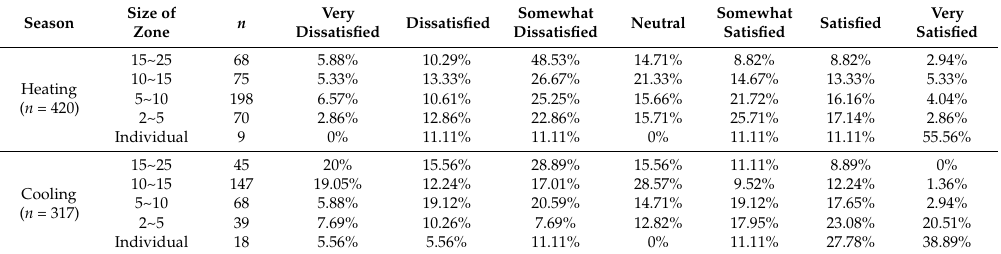
Figure 5. User satisfactions on air temperature by the size of zone (heating and cooling season, n = 737). Table 8. Descriptive statistics for user satisfaction on air temperature by the size of the zone.